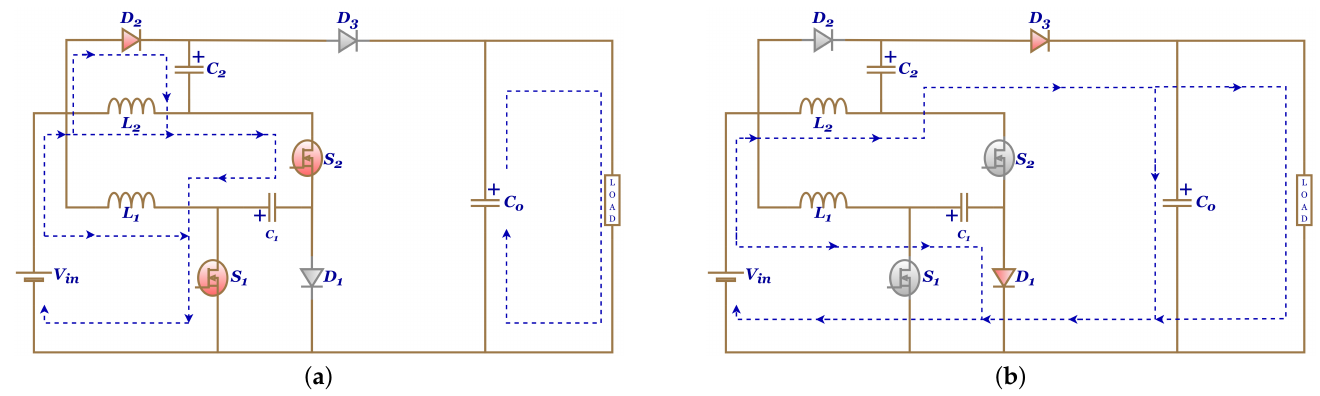
Figure 15. 3rd M-IBC operation: ( a ) S 1 and S 2 closed, and ( b ) S 1 and S 2